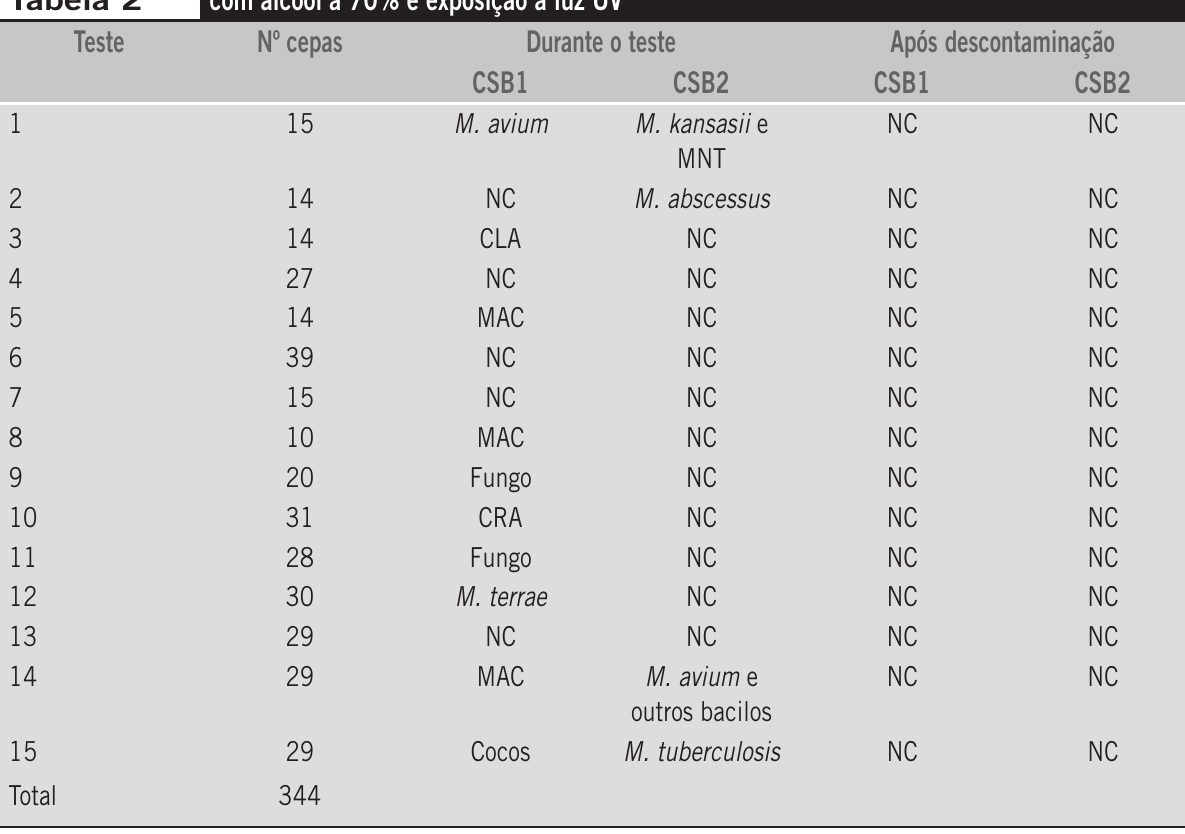
CSB: cabine de segurança biológica; NC: não houve crescimento de microrganismo; TIP: teste de identificação; CLA: micobactéria de crescimento lento acromógena; CRA: micobactéria de crescimento rápido acromógena; MAC: complexo M. avium ; MNT: micobactéria não-tuberculosa. lônias que cresceram nas placas expostas também